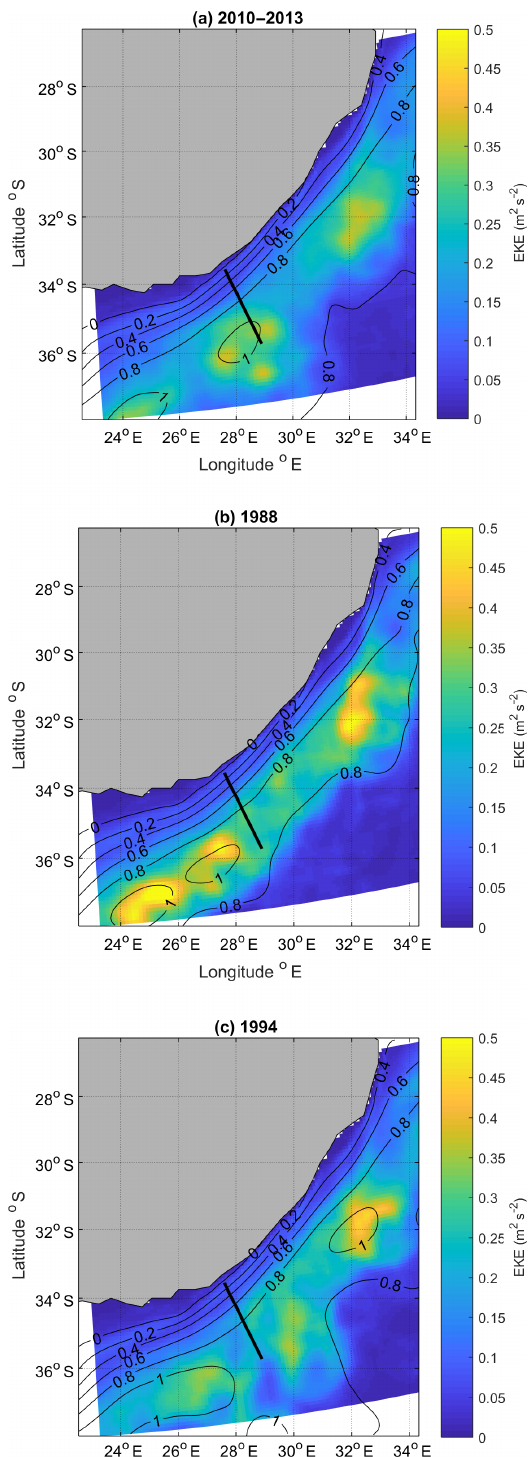
Figure 6. Eddy kinetic energy (EKE in m 2 s − 2 ) and sea surface height (SSH in metres) contours during (a) the reference period (2010–2013) (b) the highest (1988), and (c) lowest (1994) corre- lated years. The black line representing the ACT